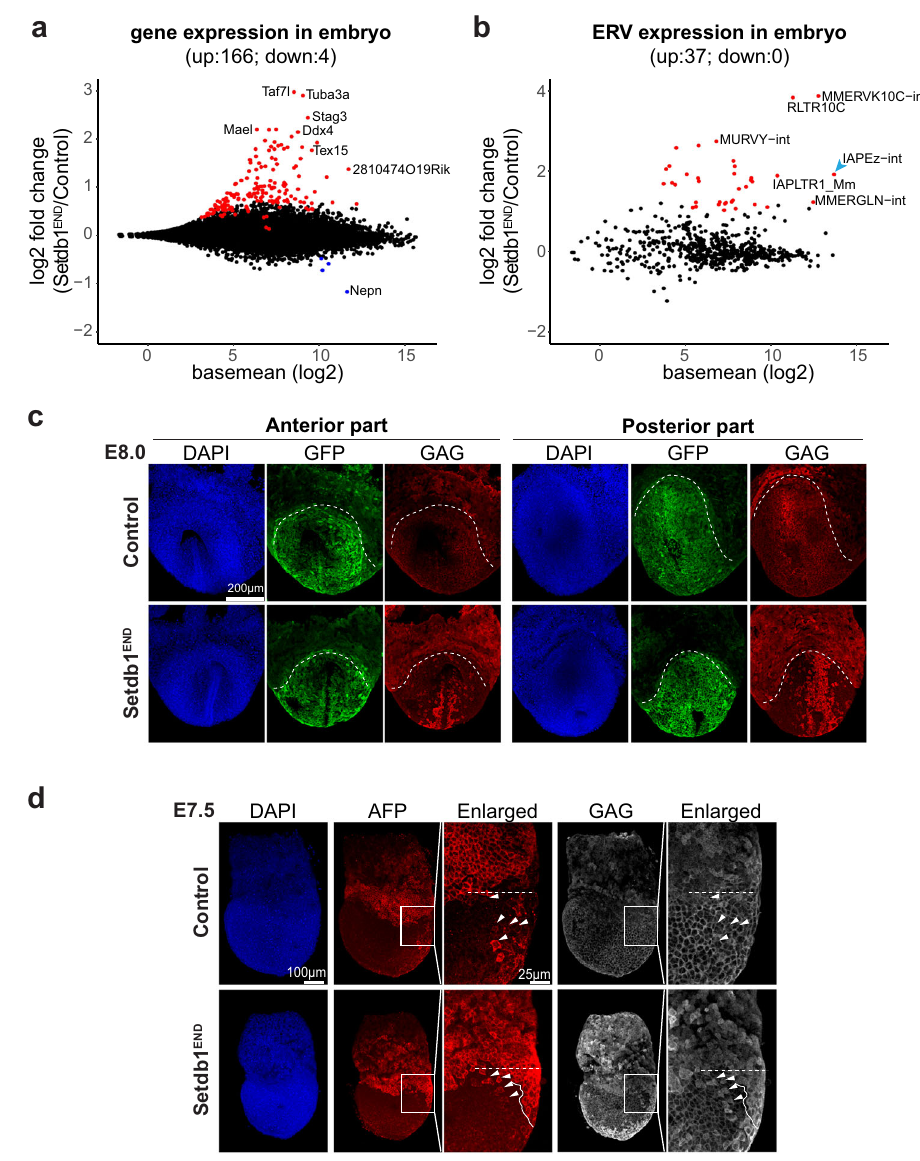
Fig. 2 | Loss of Setdb1 leads to selective de-repression of IAP elements in visc- eralendodermcells.a Dotplotshowingbasemeanexpressionvs.log2-foldchange of protein coding genes in embryonic endoderm cells. Genes with signi fi cantly changed expression (adjusted p value <0.01; n =3 for each condition) are colored (red=increased expression in Setdb1 END cells, blue=reduced expression in Setd- b1 END cells).Selectedgenesarelabeled. b Dotplotshowingbasemeanexpressionvs. log2-fold change of ERV families in embryonic endoderm cells. ERV families with signi fi cantly changed expression (Wald test with Benjamini – Hochberg correction, adjusted p value <0.01, fold change >2; n =3 for each condition) are colored (red=increased expression in Setdb1 END cells, blue=reduced expression in Setd- b1 END cells). Selected ERV families are labeled. c Whole mount immunostaining of E7.5 (Fig. 2d, region below white dashed line, cells marked by arrow- heads). Notably, we detected clear IAPEz GAG expression in these AFP positive cells, whereas most AFP negative DE cells did not display GAG expression. These data suggestthat Setdb1 knockout results in speci fi c IAPEz de-repression in the visceral, but not de fi nitive endoderm. ERV de-repression in Setdb1 -de fi cient visceral endoderm pro- genitors in vitro